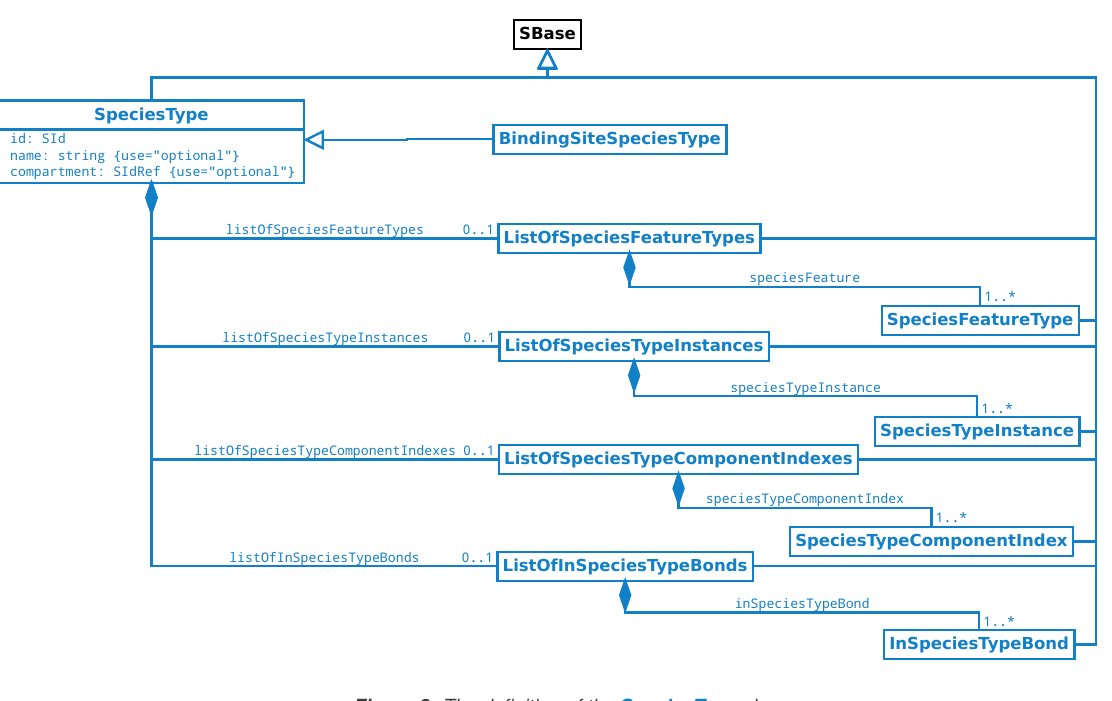
Figure 3: The definition of the SpeciesType